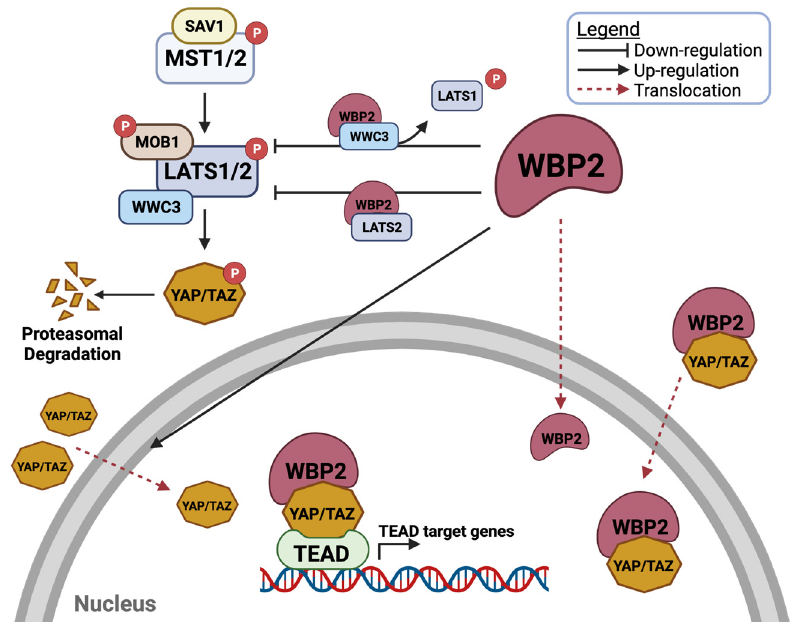
Figure 6. Regulation of the Hippo signalling pathway by WBP2. WBP2 interacts with LATS2 to inhibit the LATS2-mediated phosphorylation of YAP. WBP2 binds competitively with WWC3 to displace LATS1, hence limiting LATS1 activation. WBP2 translocates into the nucleus and interacts with YAP/TAZ to activate target gene transcription. Created with